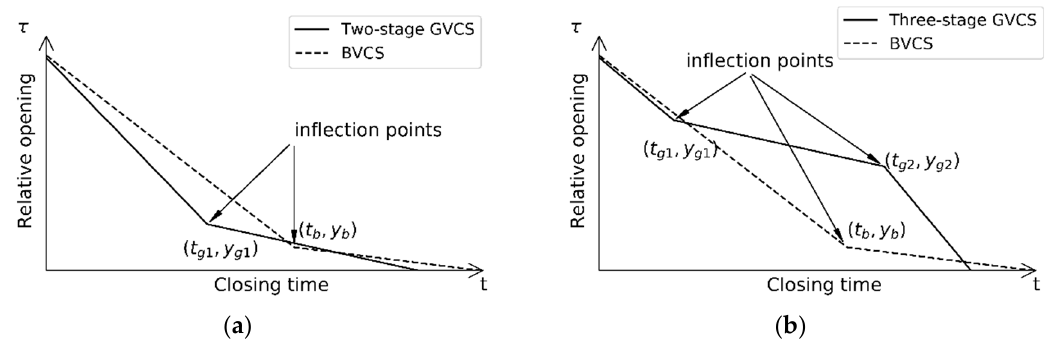
Figure 7. Closing operation of a PSP with ( a ) a two-stage guide vane closing scheme (GVCS) and ( b ) a three-stage GVCS.